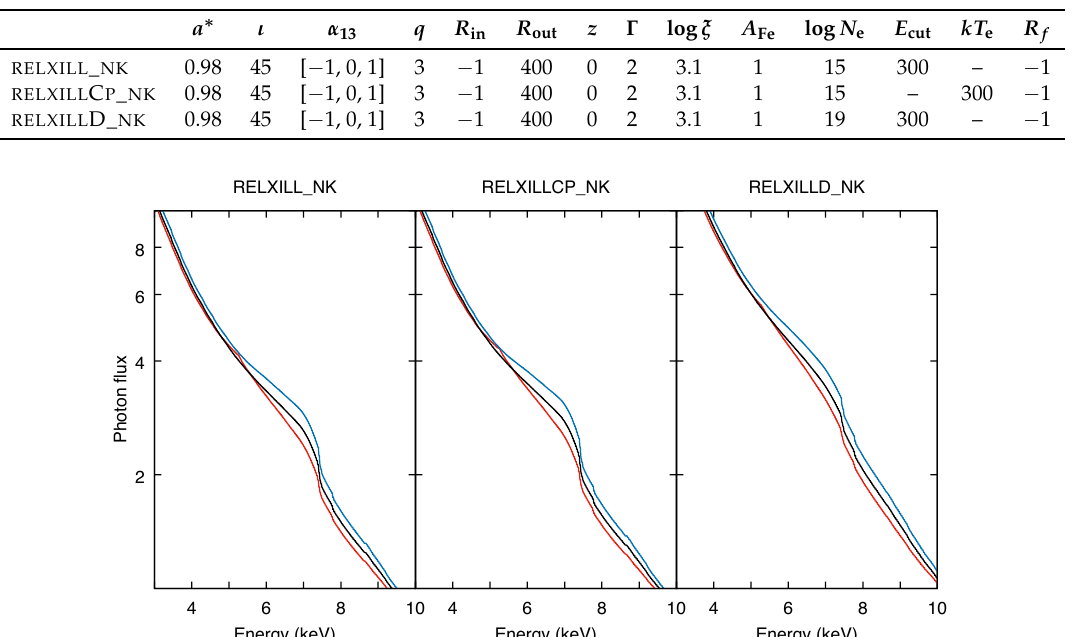
Figure 2. Comparison of RELXILL _ NK , RELXILL C P _ NK , and RELXILL D_ NK , in the Johannsen spacetime with α 13 = [ − 1(red), 0(black), 1(blue)]. Other model parameters are shown in Table